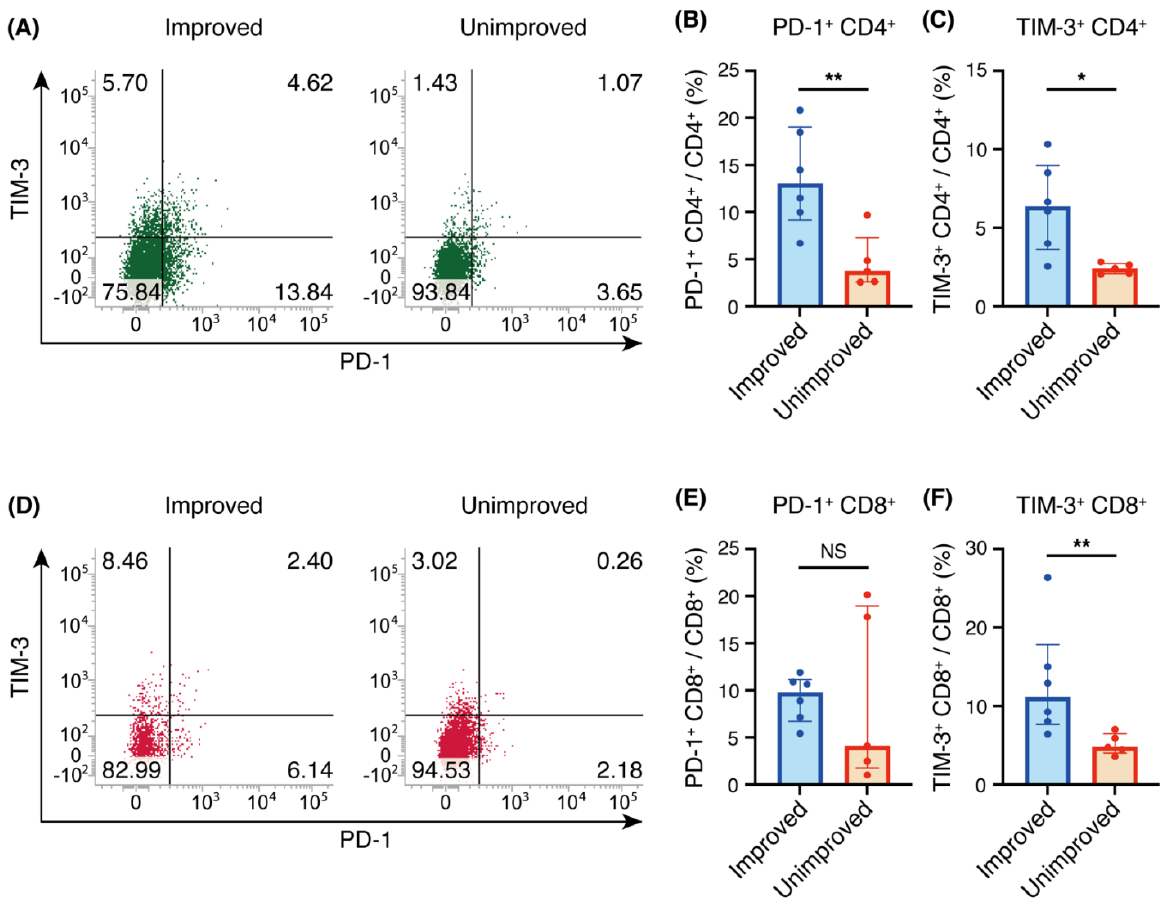
Figure 2. Programmed cell death 1 (PD-1) and T-cell immunoglobulin- and mucin-domain-containing molecule-3 (TIM-3) expression on CD4 + and CD8 + T cells in bronchoalveolar lavage fluid (BALF). ( A , D ) Representative flow cytometric analysis of PD-1 and TIM-3 expression on CD4 + T cells ( A ) and CD8 + T cells ( D ) in BALF. ( B , E ) Percentages of PD-1 + cells among CD4 + T cells ( B ) and CD8 + T cells ( E ). ( C , F ) Percentages of TIM-3 + cells among CD4 + T cells ( C ) and CD8 + T cells ( F ). ( B , C , E , F ) Individual patient data as well as medians and interquartile ranges are shown. * p < 0.05; ** p < 0.01 (Mann-Whitney U test).